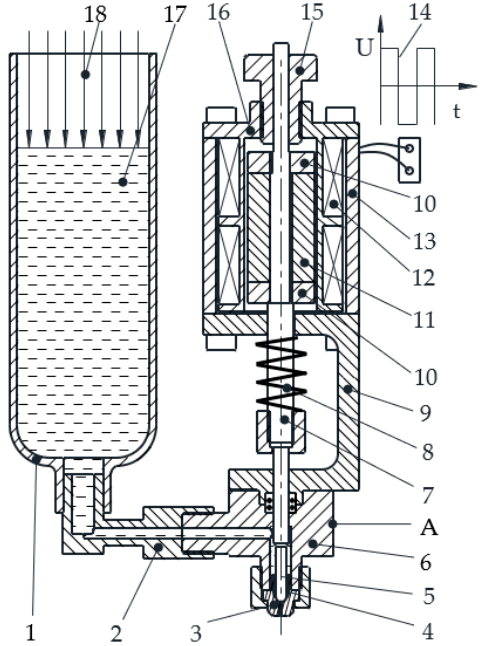
Figure 3. The moving magnet actuator (MMA) dispenser configuration. 1. Syringe; 2. fluid connector; 3. nozzle; 4. chamber; 5. ball-needle; 6. fluid body; 7. shaft; 8. return spring; 9. housing; 10. ferromagnetic disc; 11. permanent magnet; 12. coil; 13. ferromagnetic shell; 14. voltage pulse; 15. stroke adjusting nut; 16. bobbin; 17. fluid; 18. pressurized air; A. temperature checkpoint.